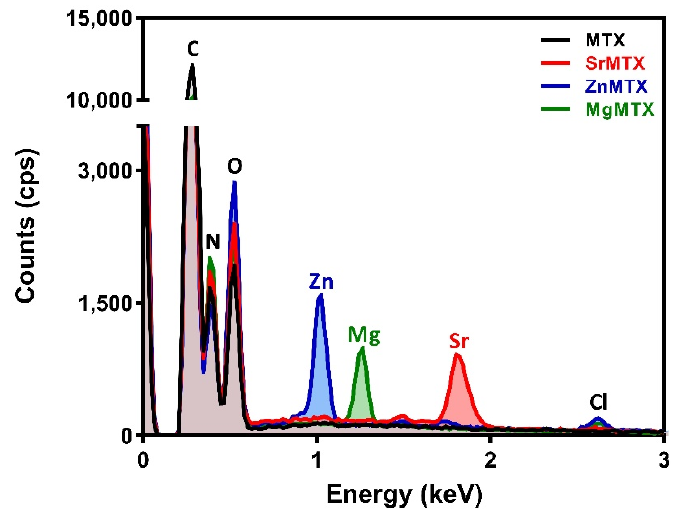
Figure 2. EDAX spectra registered for MTX and its derivatives.